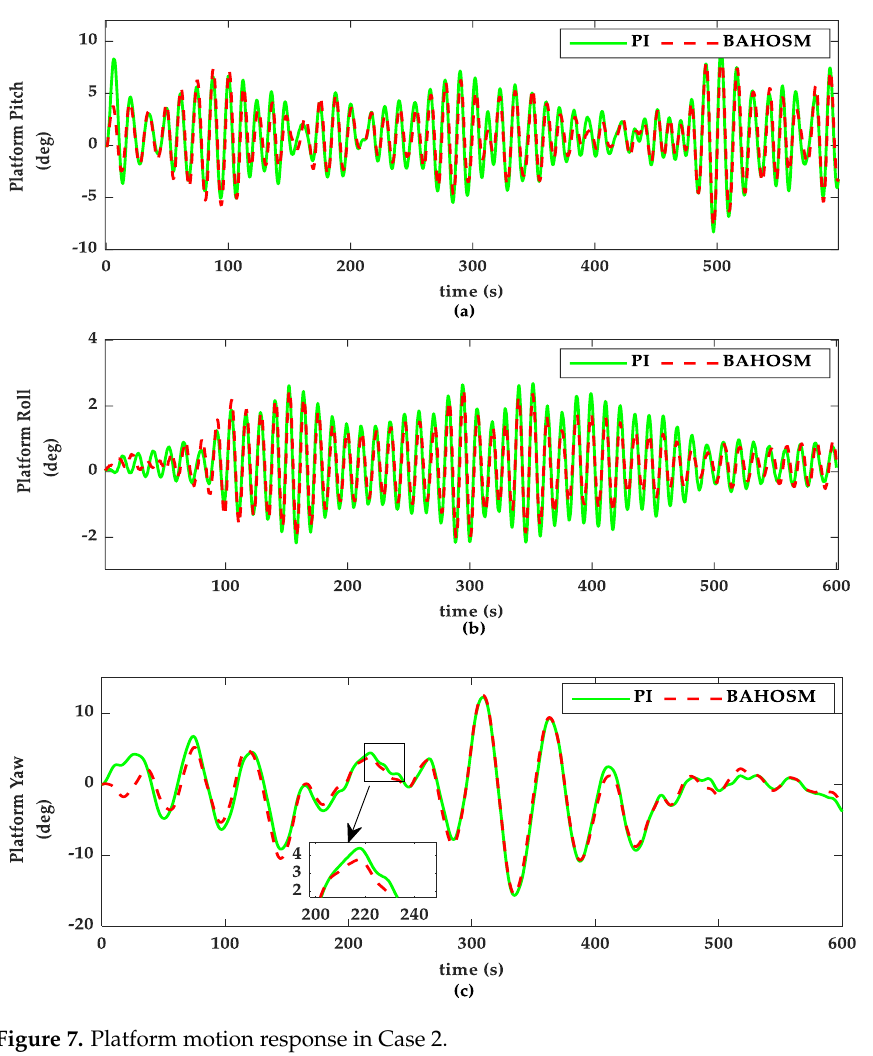
Figure 7. Platform motion response in Case 2.